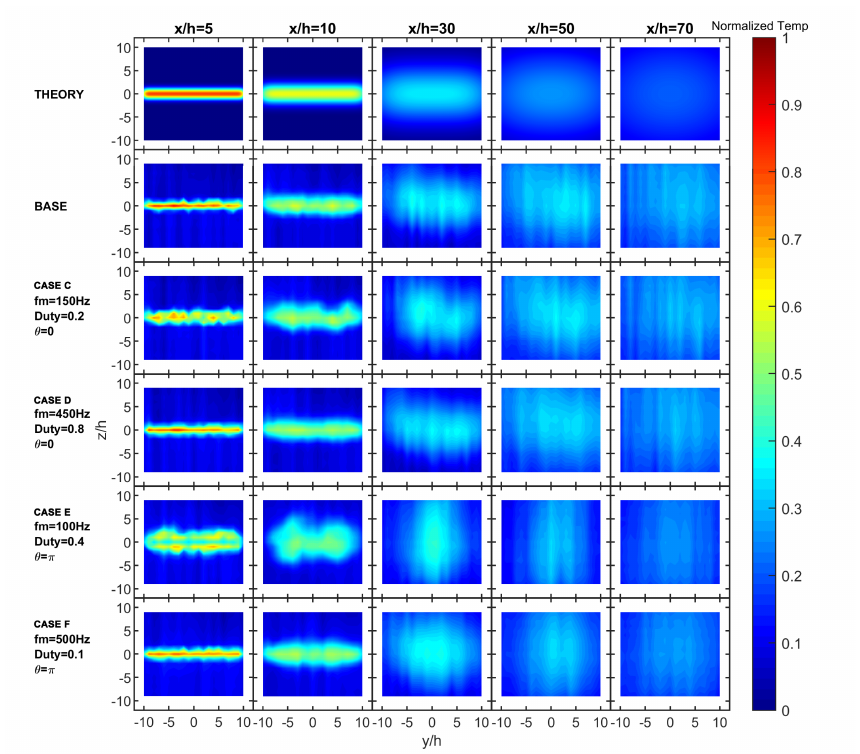
Figure 22. Normalized temperature contour plot on yz cut section where x / h = 5, 10, 30, 50, and 70 for different cases.